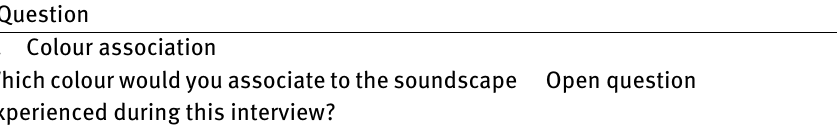
Table 1: Questions included in the poll used for the present